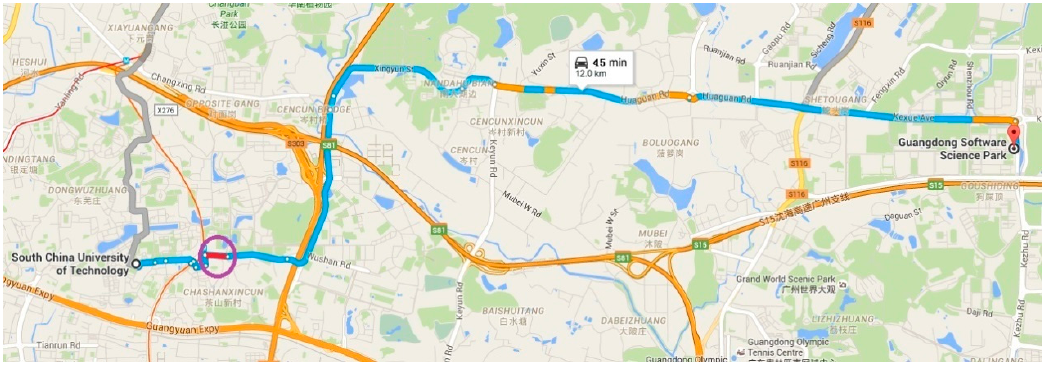
Figure 8. Route planning based on traditional algorithm.